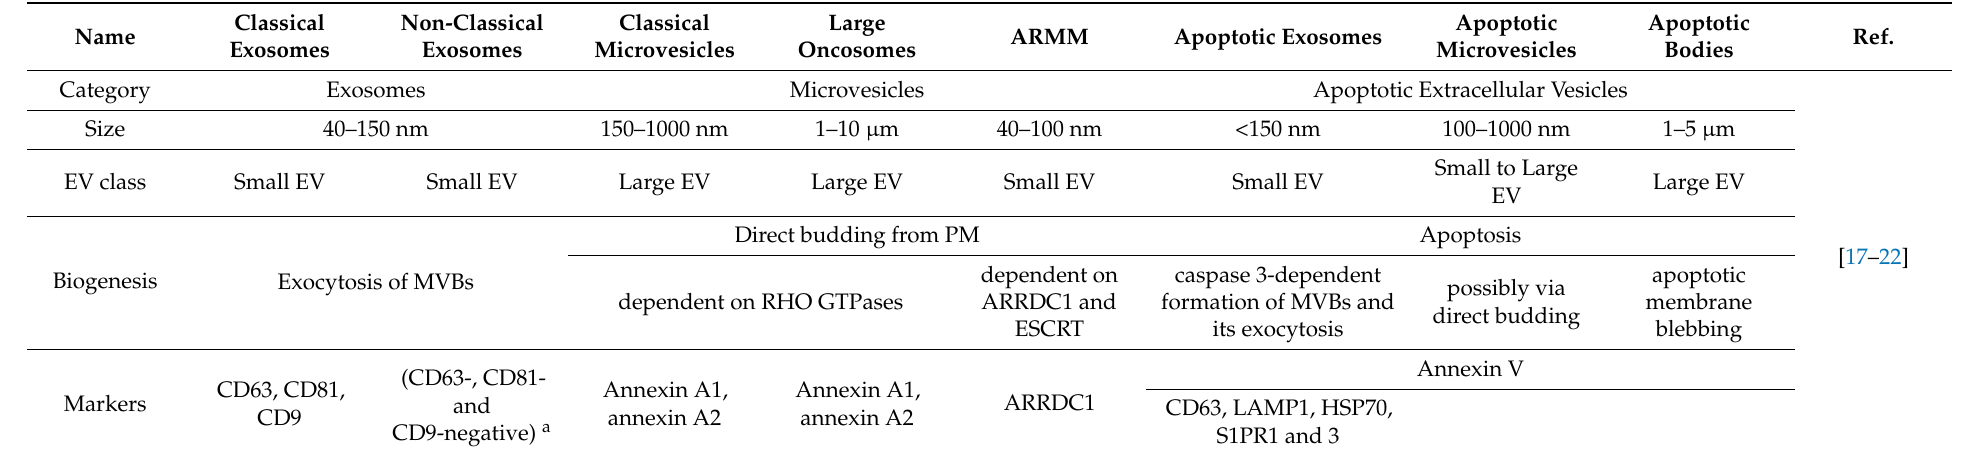
Table 1. Main types of extracellular vesicles and their different